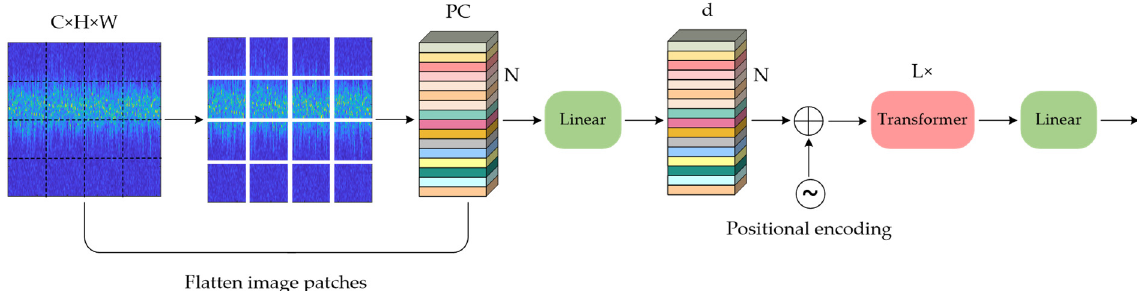
Figure 7. Standard Vision Transformer.